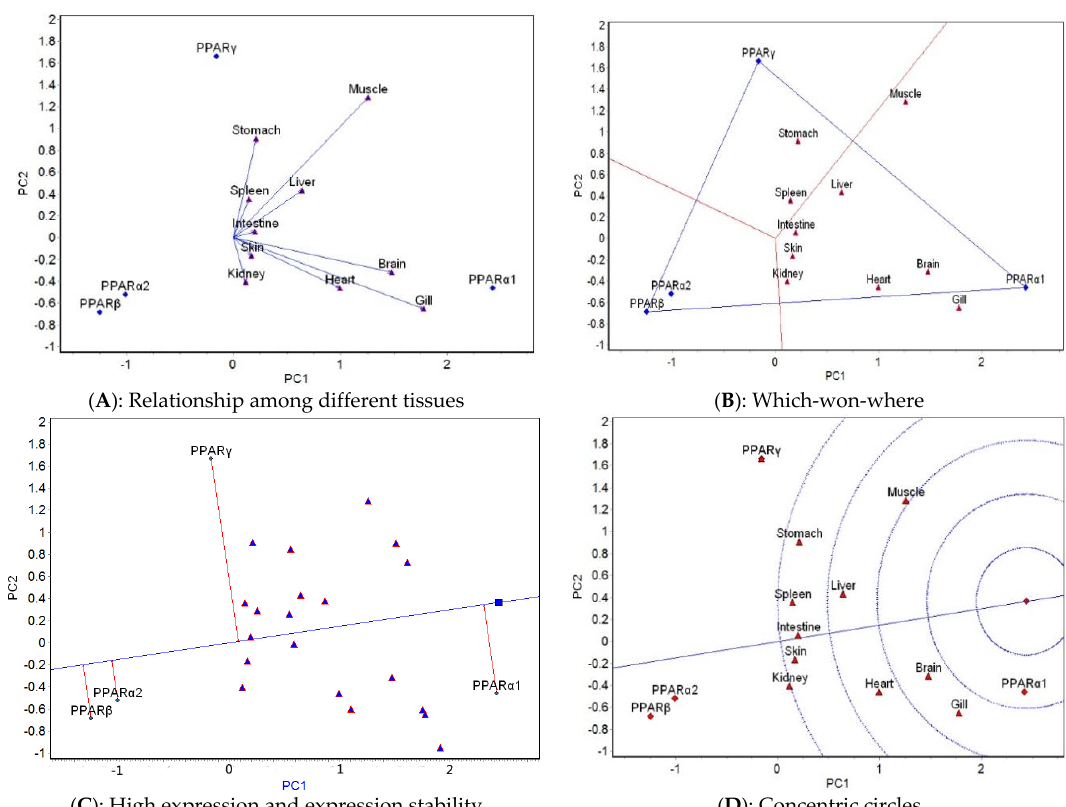
Figure 5. GGE biplots of PPAR genes in different tissues at 23 °C.